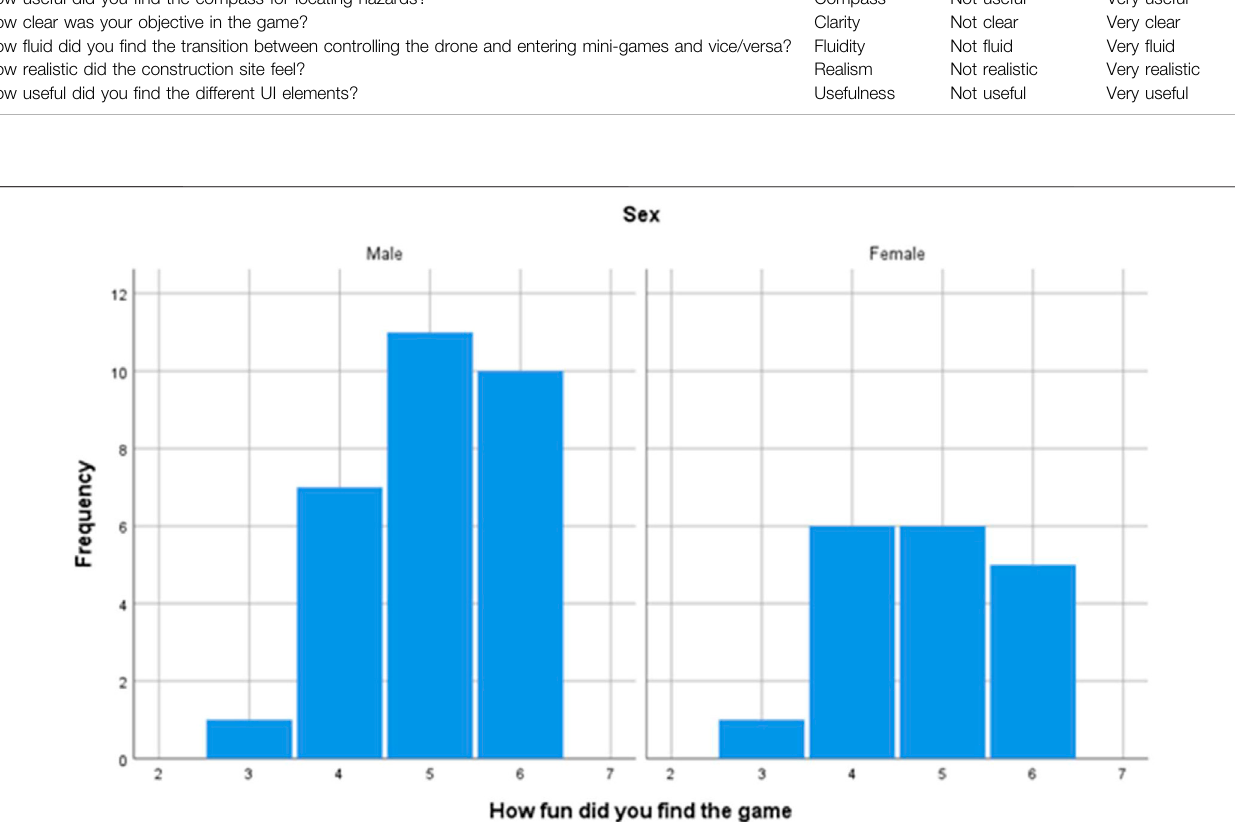
Frontiers in Built Environment |